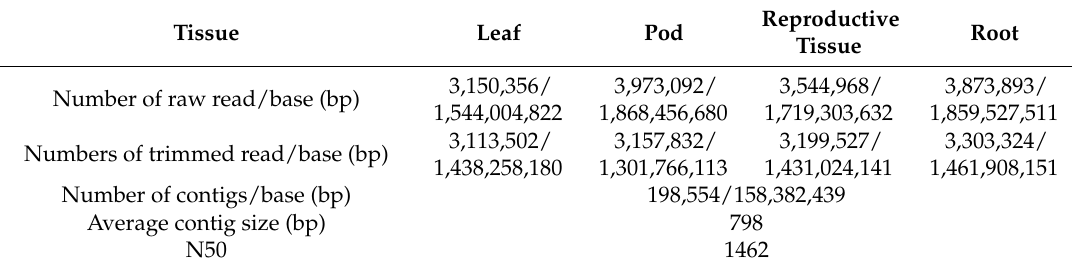
Table 2. Summary statistics for the de novo assembled